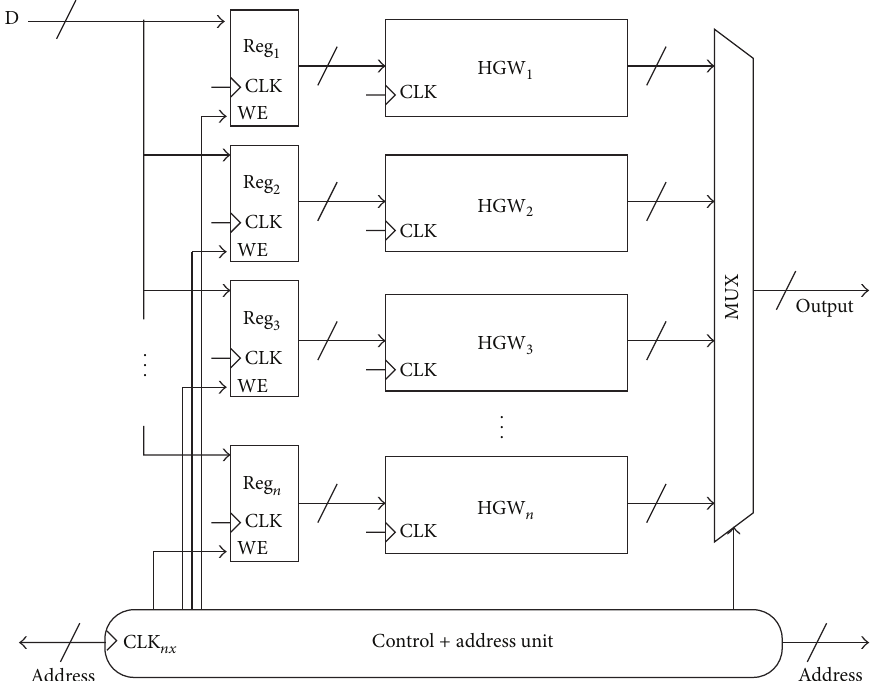
Figure 5: Organization of several HGW processing units to exploit function-level parallelism. The address generator unit works at a clock speed 𝑛 times faster than the computational